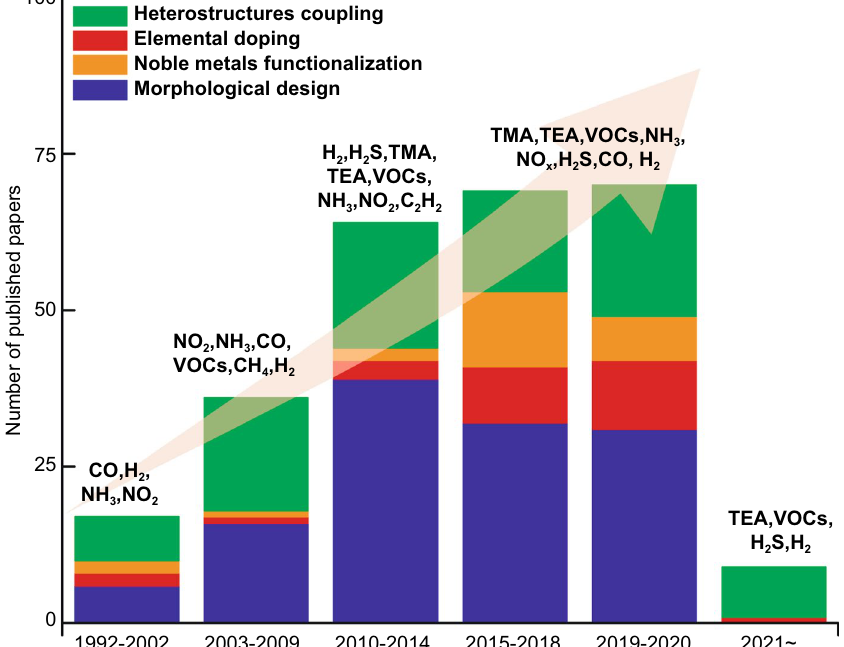
Fig. 2 Number of publications examining various strategies to improve gas sensing properties of MoO 3 toward wide range of gases. Data are collected from Web of Science (WoS) as of April 2, 2021, with the keyword “MoO 3 gas sensing.” Both experimental and computational works are included. Review and perspective articles are excluded from the collected data. TMA and TEA stand for trimethylamine and triethylamine,